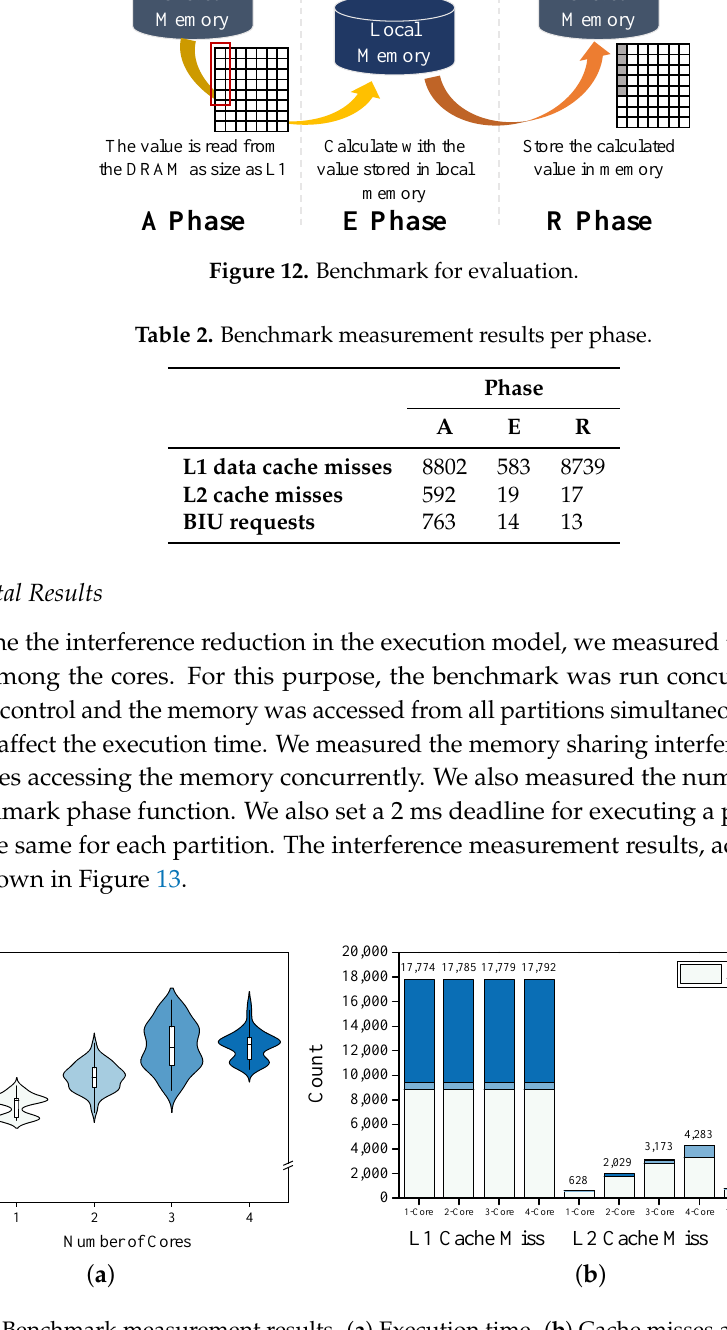
Figure 13. Benchmark measurement results. ( a ) Execution time. ( b ) Cache misses and bus interface unit (BIU)